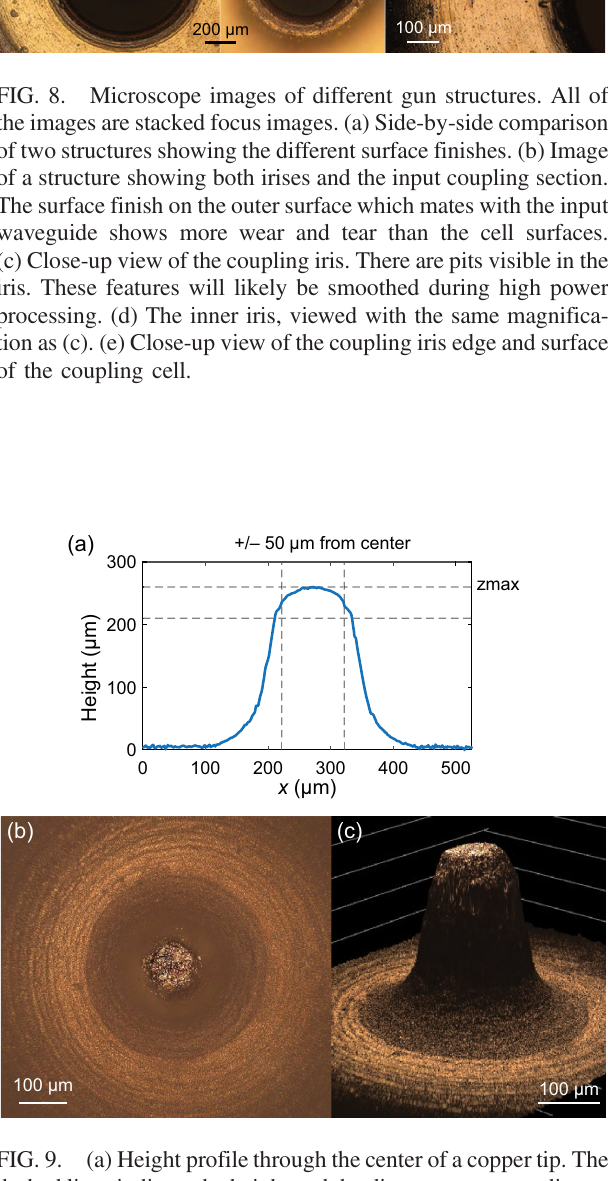
FIG. 9. (a) Height profile through the center of a copper tip. The dashed lines indicate the height and the distance corresponding to a 50 μ m radius, the design value. The tip is not a perfect hemisphere, but its overall size matches well with the design. The height from the baseline is 255 μ m, which was the design value for the height. (b) Top-down view of a tip in a stacked-focus image. (c) Height data displayed in 3D form.